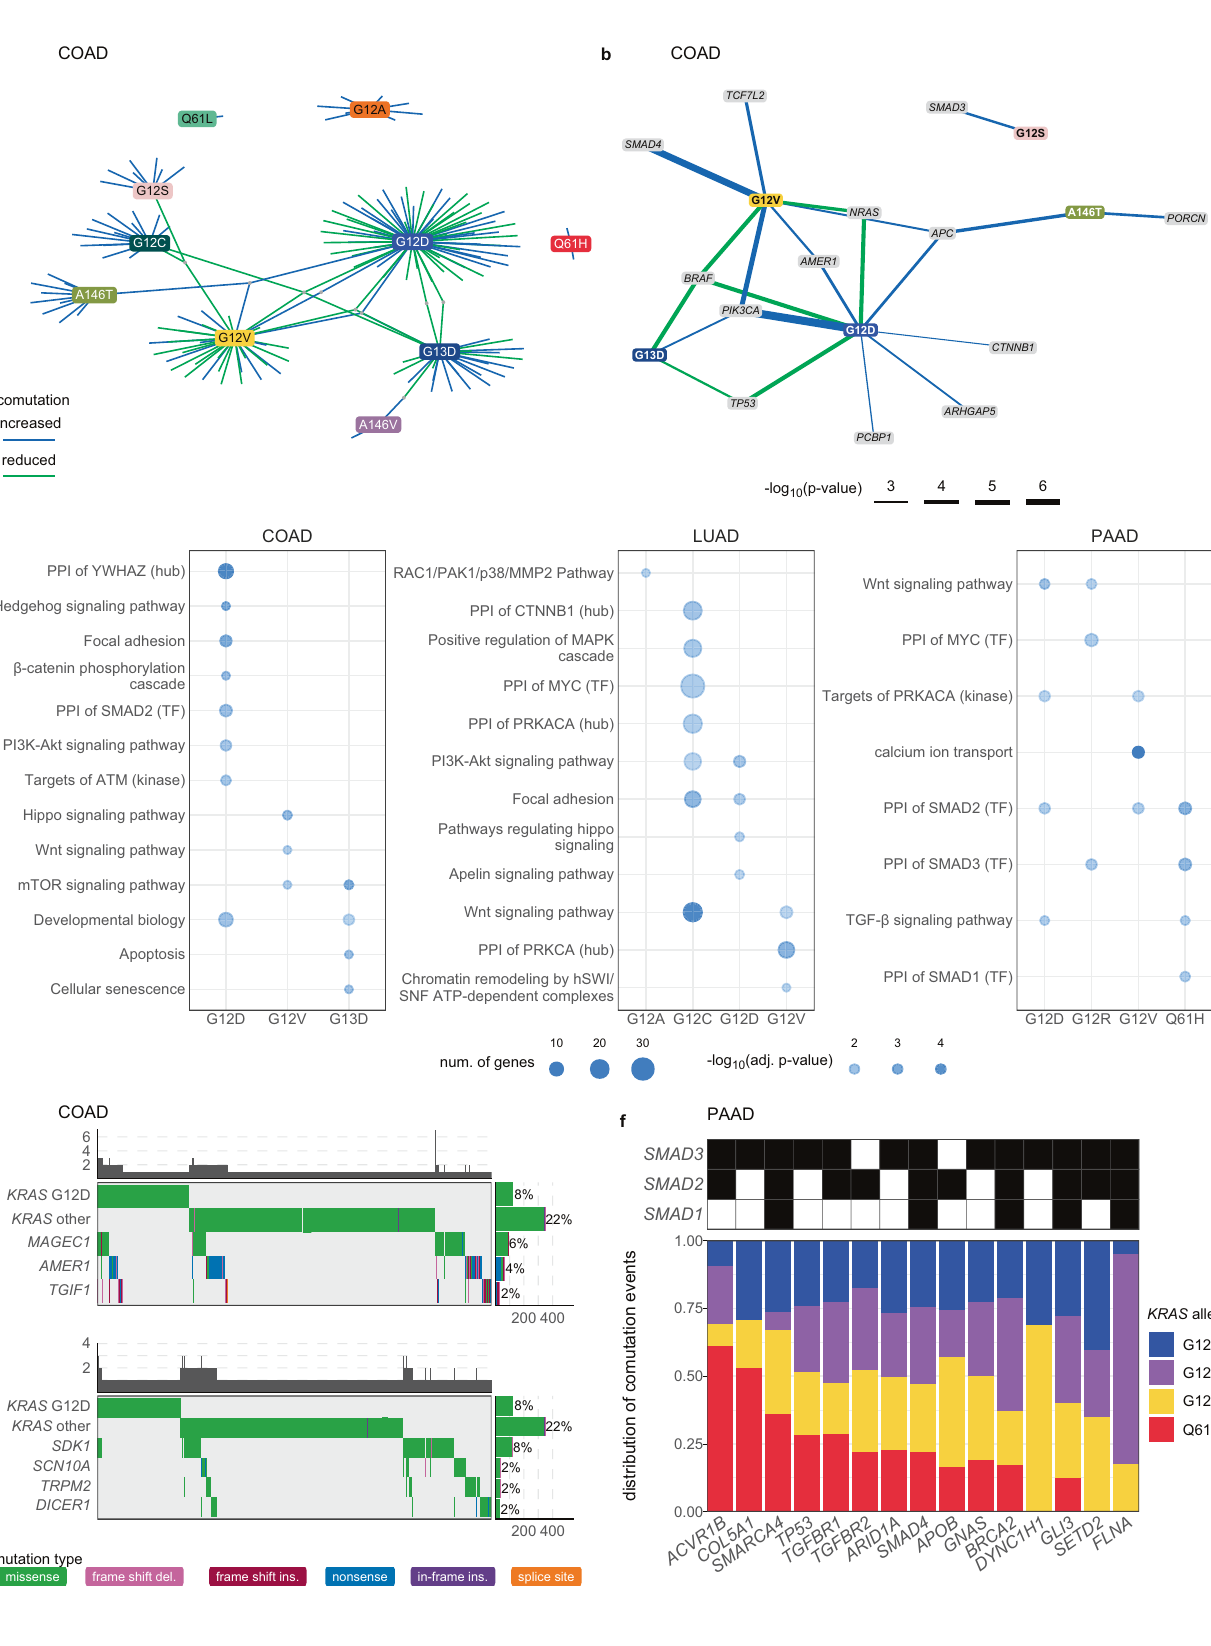
mutation frameshiftins. nonsense in-frameins. splicesite